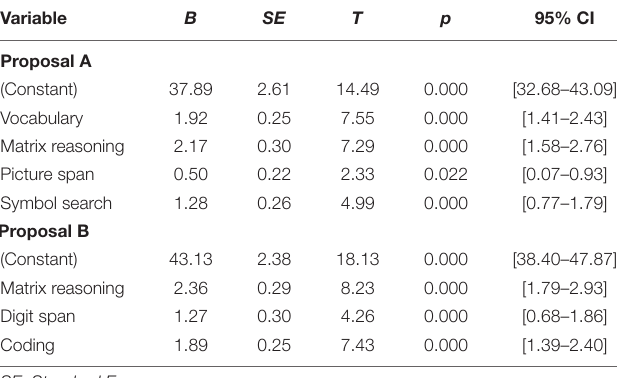
TABLE 2 | Linear regressions between short-forms and FSIQ.